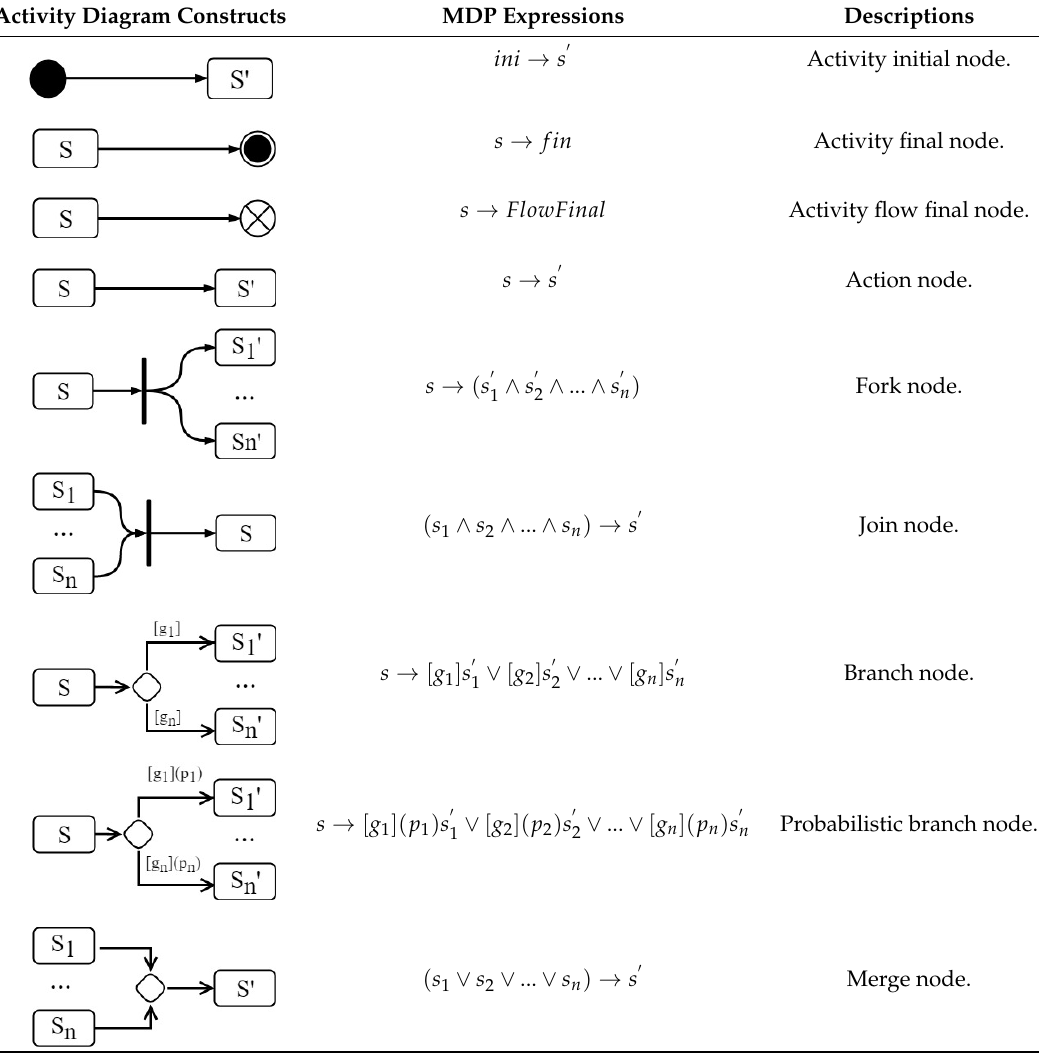
Table A1. Mapping rules between MDP expressions and SysML activity diagram